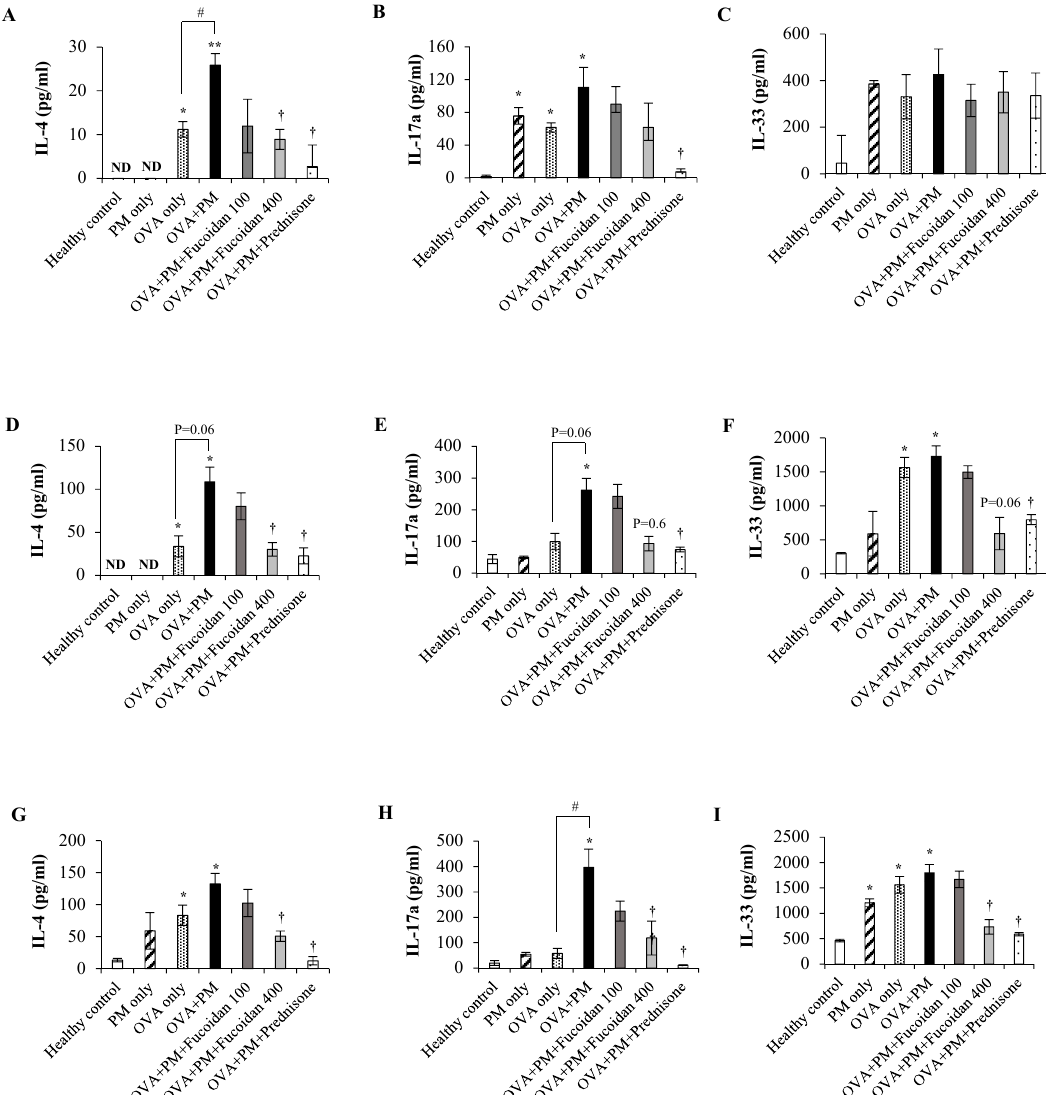
Figure 12. Protein levels in the serum of ( A ) IL-4, ( B ) IL-17a, ( C ) IL-33, BALF: ( D ) IL-4, ( E ) IL-17a, and ( F ) IL-33 and, lung: ( G ) IL-4, ( H ) IL-17a, ( I ) IL-33 were measured using ELISA. Values are expressed as means ± SEM ( n = 3). * ( p < 0.05), ** ( p < 0.005) represent significant increases compared with the untreated control, and † ( p < 0.05) represents a significant decrease compared with the OVA + PM group. # ( p < 0.05) represents a significant increase compared with the OVA only group. ND; not